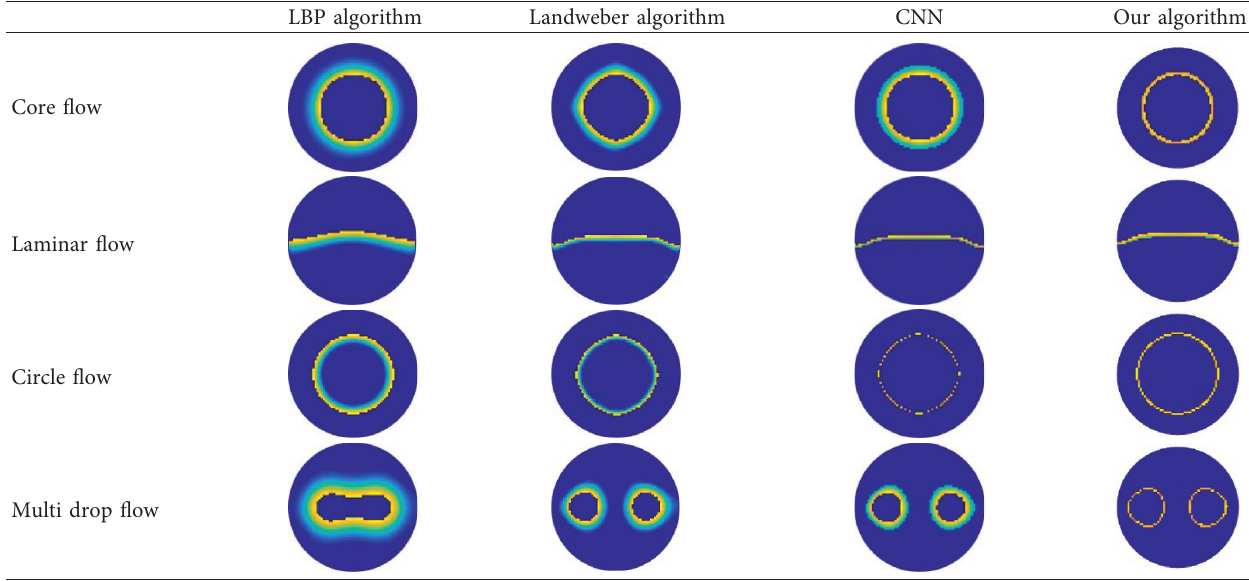
Figure 7: Arc artifact: (a) LBP algorithm to reconstruction and (b) arc artifacts in reconstruction. Table 9: Artifact